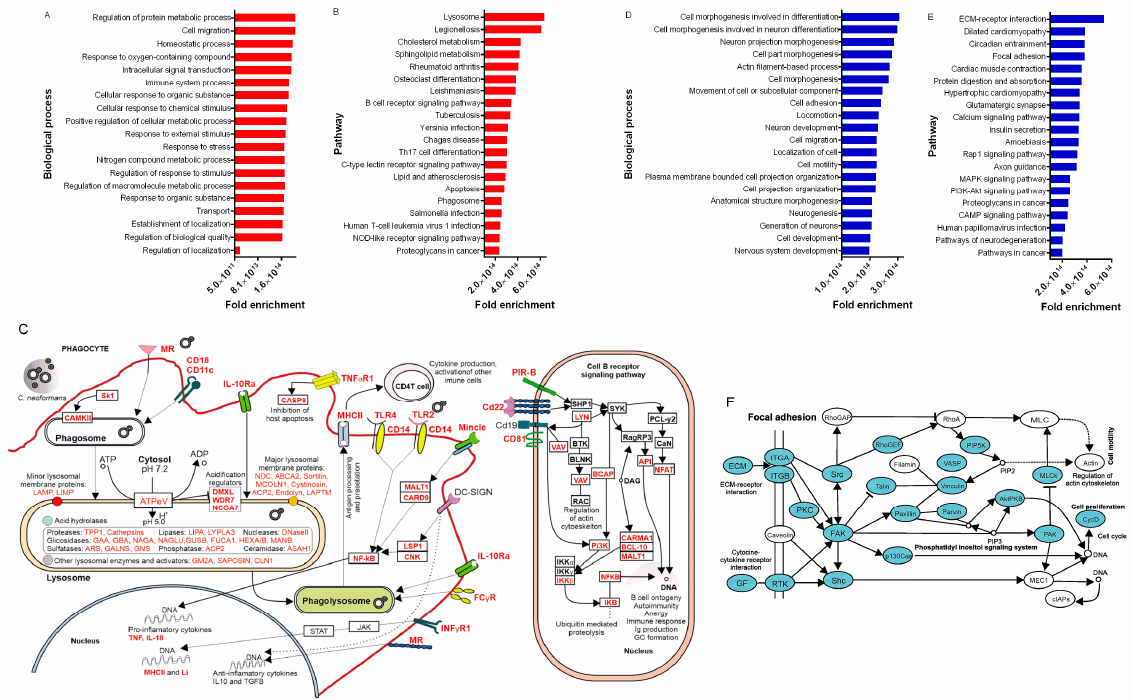
Figure 6. In situ transcriptional profile in the early and late mouse response to C. neoformans infection. Genes are upregulated at 6 h compared to 10 d. ( A ) Biological processes and ( B ) pathways enriched in the BS of mice 6 h post infection. ( C ) Gene regulation of phagocytosis and B-cell receptor signaling in the BS. After deposition in the lungs, C. neoformans can be recognized by pattern recognition receptors (MR, CD18, CD11C, DC-SIGN, TLR4, and TLR2) on phagocytes and internalized, leading to the formation of the phagosome and consequently the phagolysosome. The acidification of this compartment combined with respiratory burst and degradative enzymes are important factors for antimicrobial activity. After the degradation of C. neoformans in the phagolysosome, microbial antigens can be targeted to the MHC-II pathway for presentation to CD4 T cells. Furthermore, cell wall components of C. neoformans (GXM, GalGXM, and mannoproteins) can also be recognized by B-cell receptors, leading to signaling for antibody production. Upregulated genes in red. Based on KEGG and Gene Ontology (GO) analyses. Genes are upregulated at 10 days compared to 6 h. ( D ) Biological processes and ( E ) pathways enriched in the BS of mice 10 days post infection. ( F ) Focal adhesion pathway showing the upregulated genes (blue) in the BS 10 days post infection. Based on KEGG and Gene Ontology (GO) analyses.